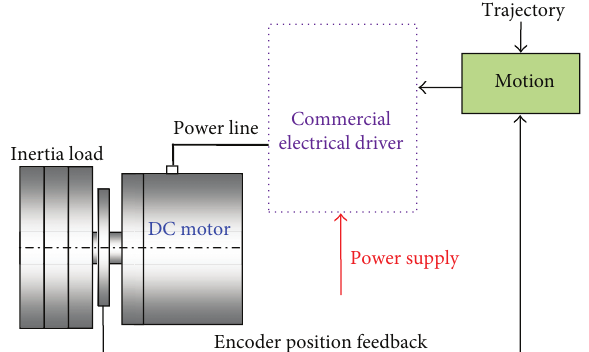
Figure 1: The architecture of the positioning motion system driven by DC